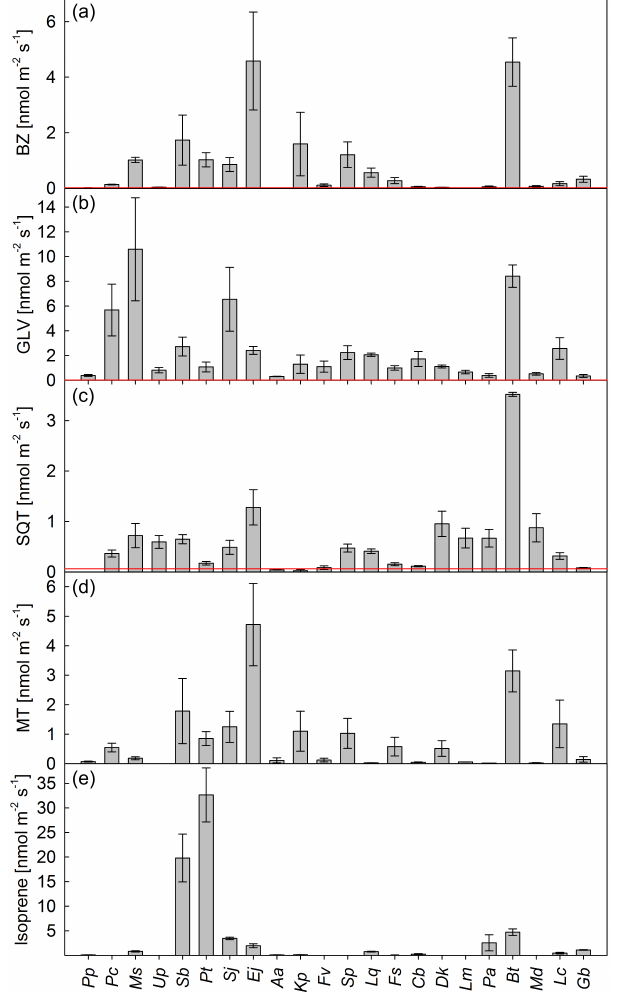
Figure 3. BVOC emission rates from 22 broadleaf tree species that are commonly found in the urban area of Beijing. The species were sorted by the phylogenetic tree based on the taxonomic data (Fig. 5). (a) BZs benzenoids; (b) GLVs green leaf volatiles; (c) SQTs sesquiterpenes; (d) MTs monoterpenes; (e) isoprene. For the sBVOC in panels (a) – (c) , the red lines indicate the double max- imum emission rates between all of the unstressed model plants of Fig. 1a to each sBVOC group. For graph clarity, the MT emissions were not divided into constitutive and stress-induced categories, the latter being marginal compared to the total MT emissions.